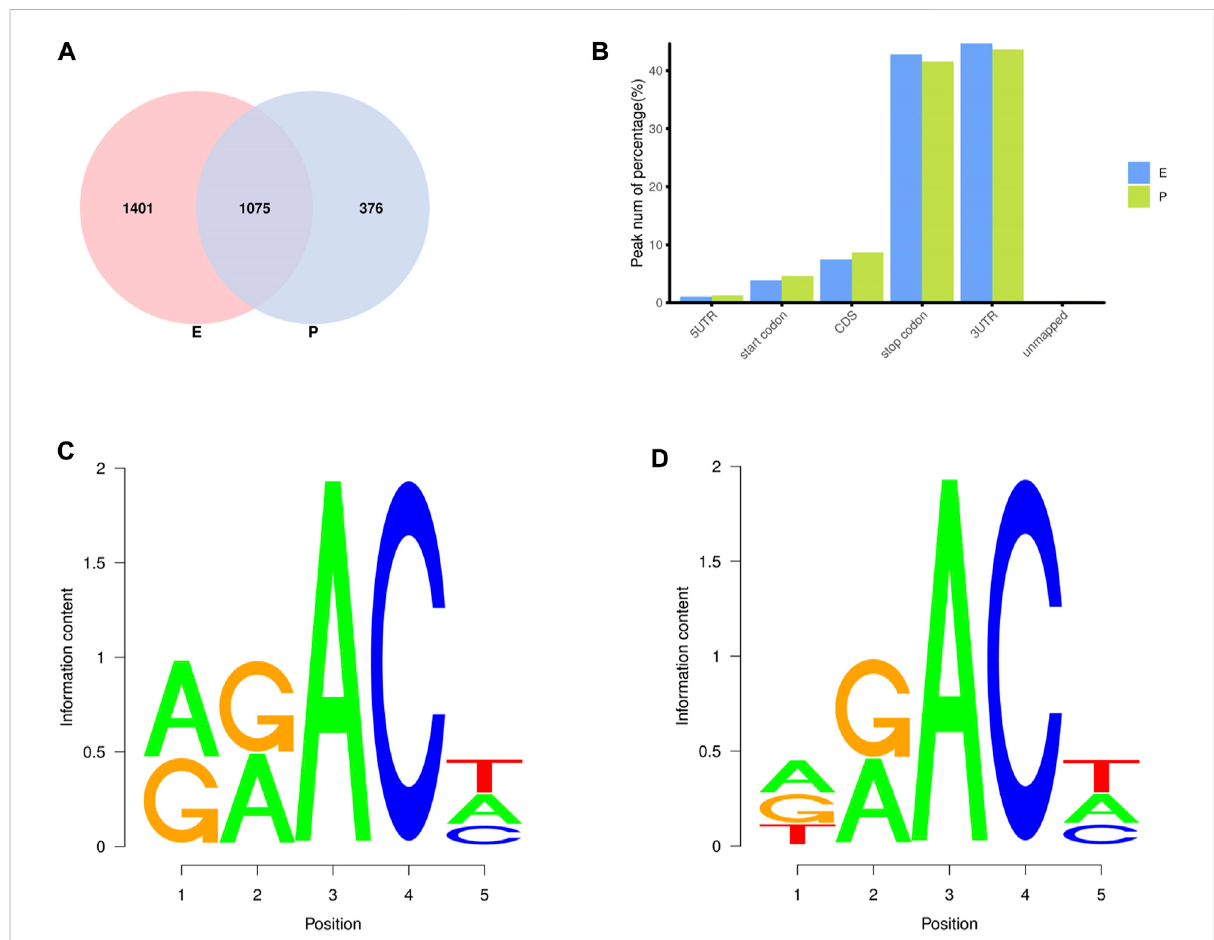
FIGURE 2 Regional distribution and motif sequence of m 6 A modi fi cations on transcripts. (A) Peak distribution of m 6 A modi fi cations in early and peak lactation. (B) The distribution ofm 6 Aintranscripts (C) and (D) Twocommon motifswith thehighestm 6 A abundance. Erepresentstheearlylactation, P represents the peak lactation, the following are the